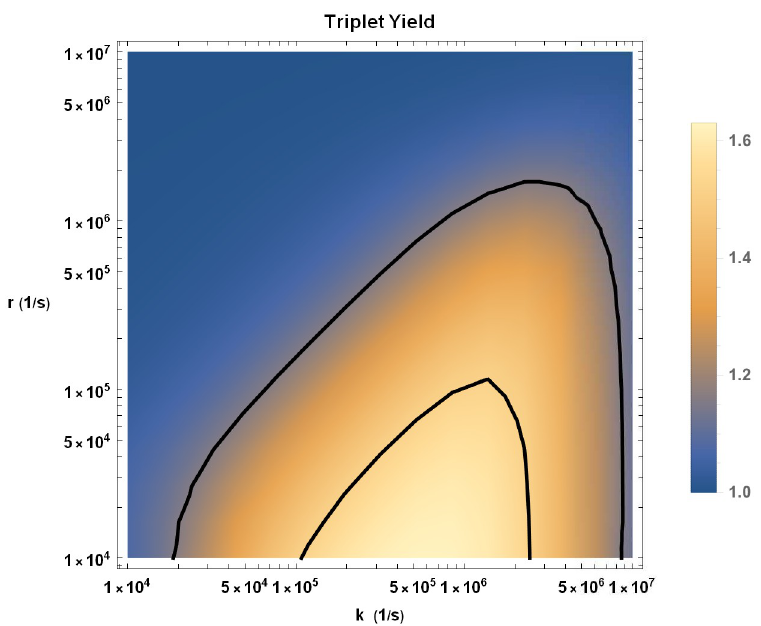
Fig 3. Triplet yield ratio (GMF to HMF) for singlet-born RP in the k − r plane. The region between the solid black lines (1.16 and 1.52) is in agreement with the experimental range for the ratio of the numbers of BrdU+ cells after an 8 week exposure to GMF and HMF(1.34 ± 0.18) [25]. The value of HFCC a 1 is taken to be a 1 = − 802.9 μT [47].